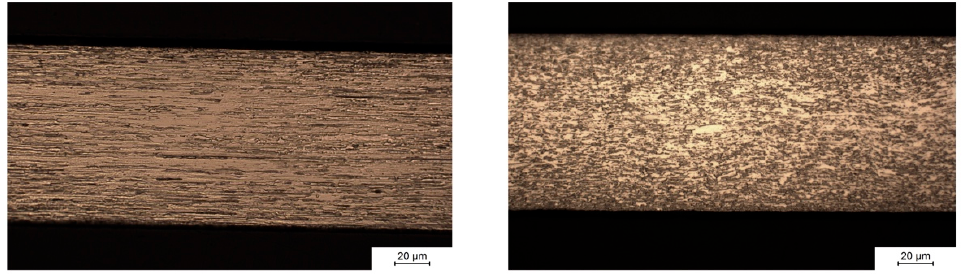
Figure 11. Mo sheet microstructure. Cross sections in parallel to the direction of hot rolling (left image) and perpendicular to the direction of hot rolling (right image).